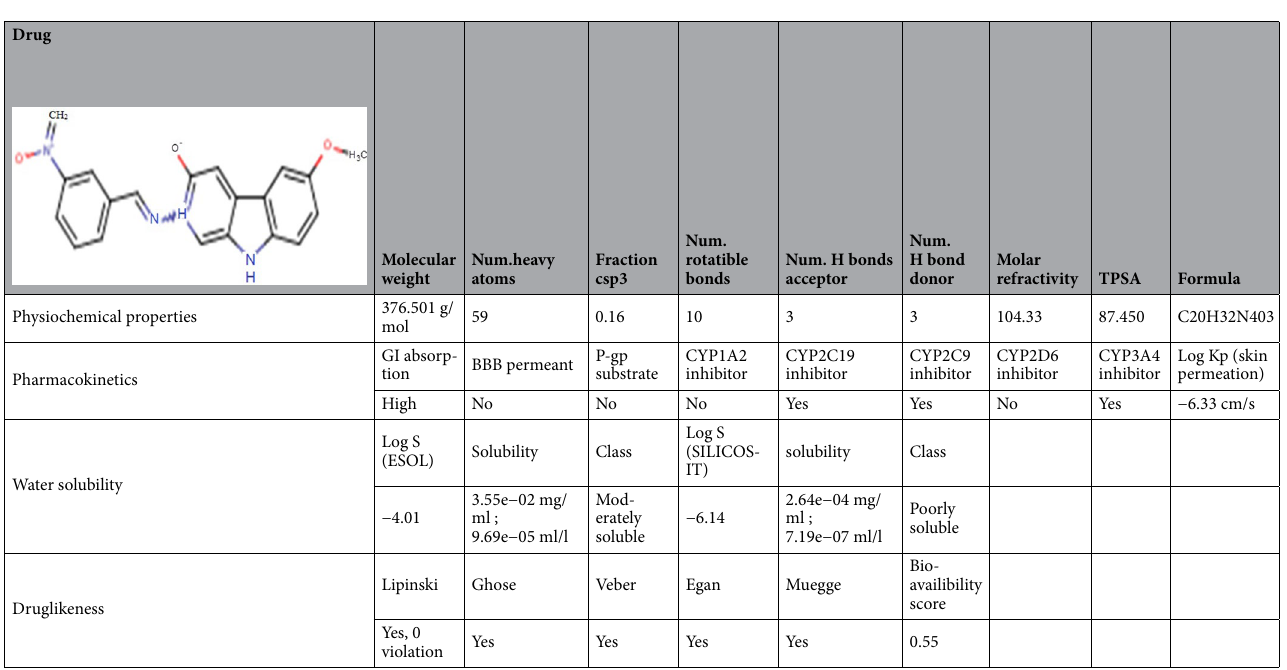
Table 4. Molecular descriptors of MMINA through in silico QSAR